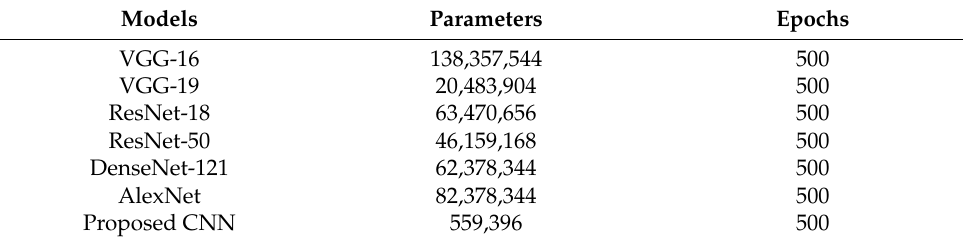
Table 6. Characteristics of the CNNs’ architectures used in this paper.